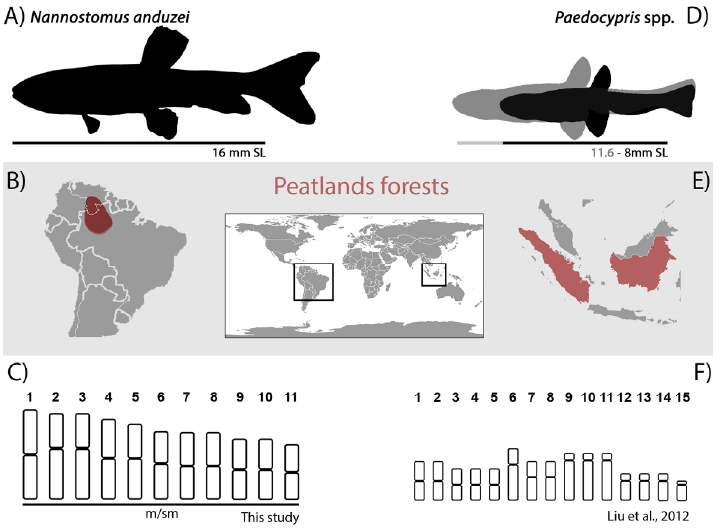
Figure 4. The main similarities between N. anduzei (( A – C ) in this research) and Paedocypris spp. (( D – F )—[19]). ( A , D ) Representation of an adult specimen of N. anduzei with SL = 16 mm and Paedocypris spp. with SL = 8 mm. ( B , E ) Geographical maps with the distribution of both species and peatland forests highlighted in red. ( C , F ) Idiograms of both species’ chromosomal complements are dominated by large bi-armed chromosomes, revealing their probable fusion origin.